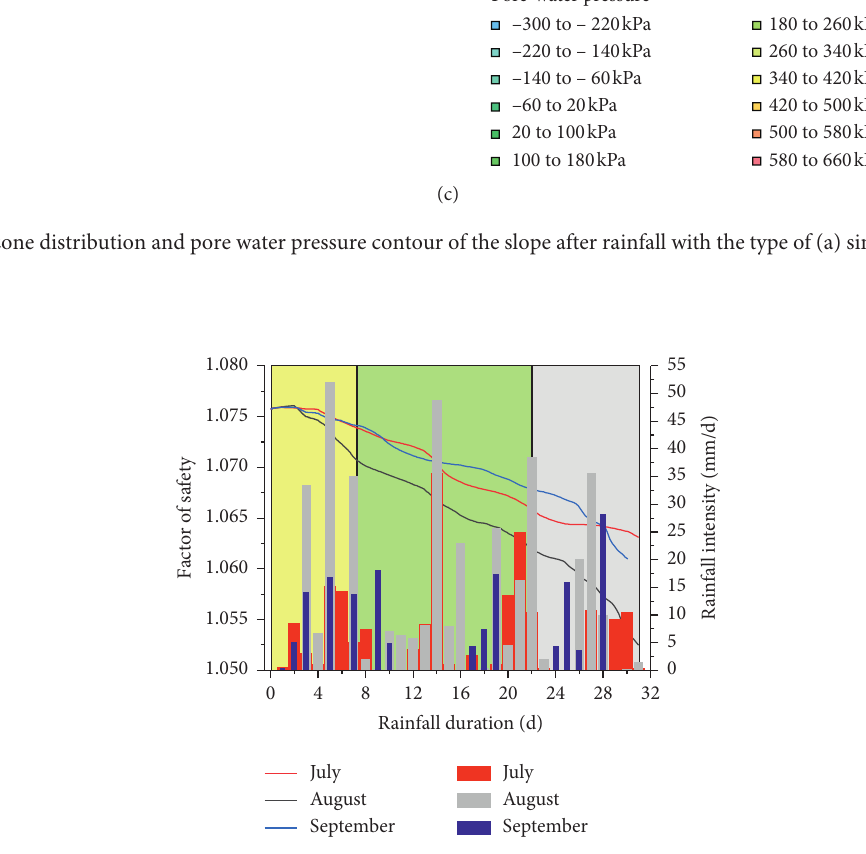
Figure 11: Factor of safety of the potential sliding surface of the slope subjected to different rainfall patterns.